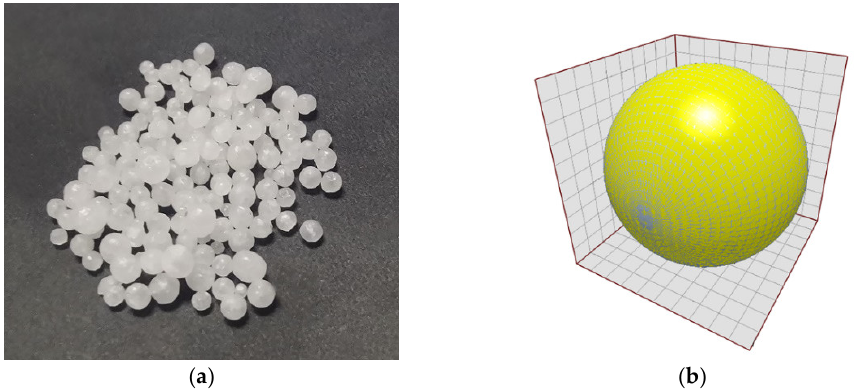
Figure 6. Urea particles and its discrete element model: ( a ) Urea particles; ( b ) Discrete element model of urea particles.